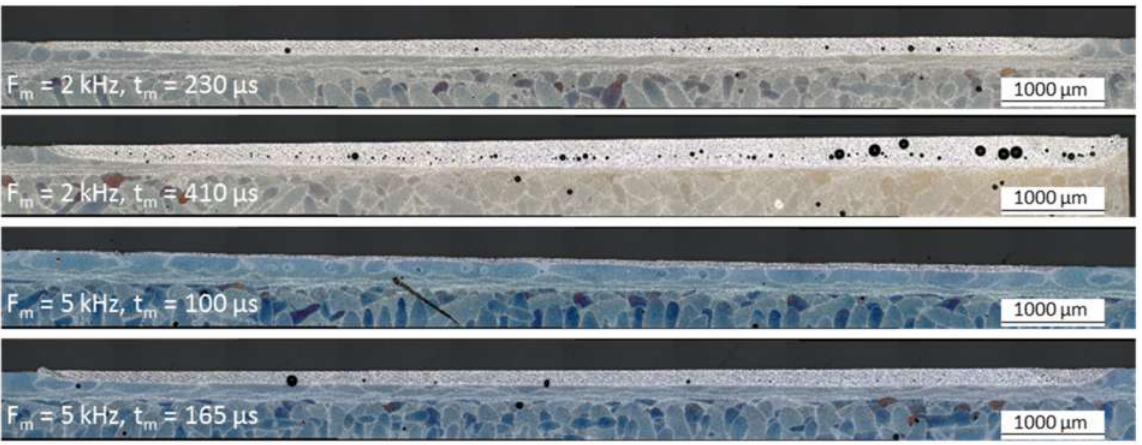
Figure 16. Etched cross sections of the remelting zone in direction of the axis